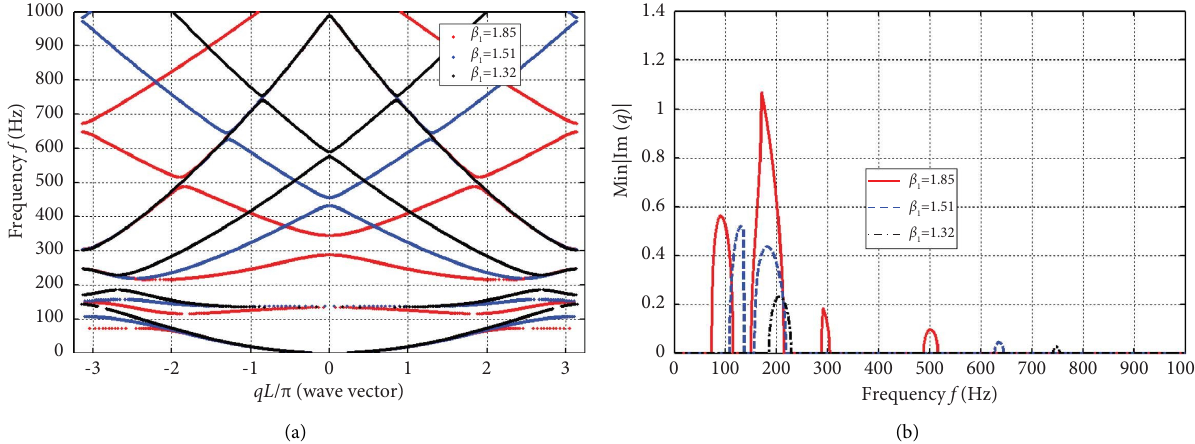
Figure 12: Efects of geometric parameters of beams on bandgap of metamaterial: (a) efects of geometric parameters on bandgap and (b) efects of geometric parameters on attenuation constant.